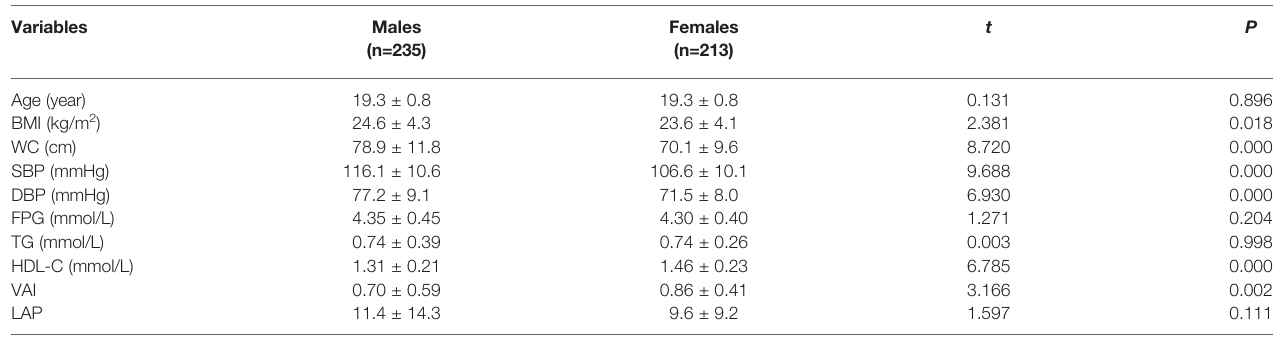
TABLE 1 | General characteristics of participants.